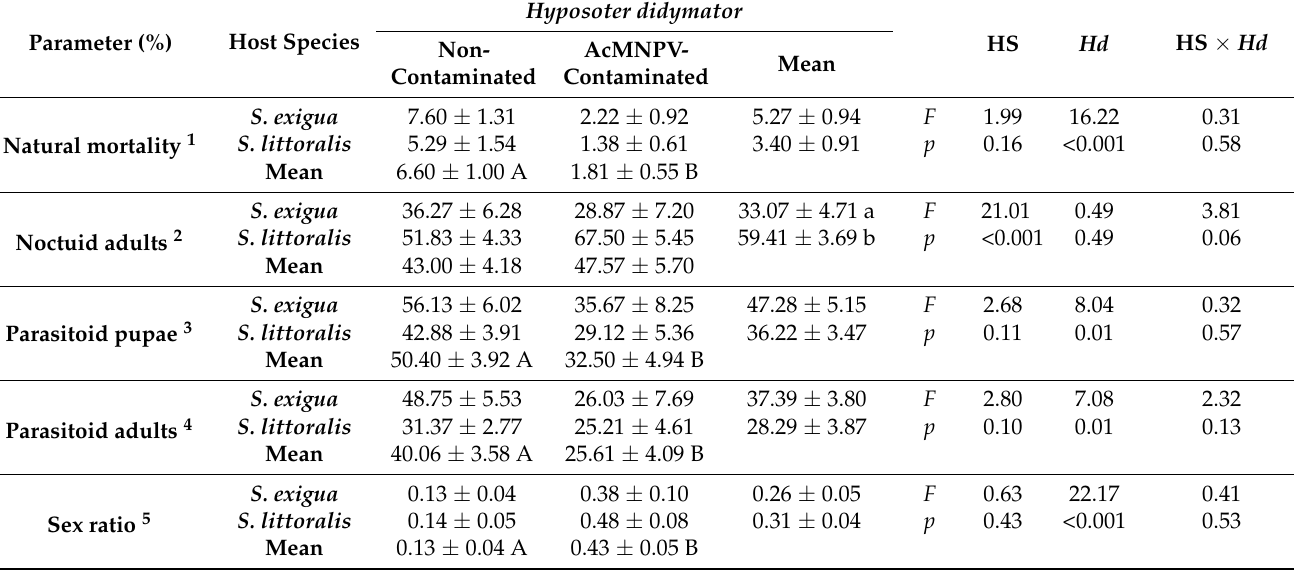
Table 2. Preference of Hyposoter didymator females for Spodoptera exigua and Spodoptera littoralis larvae under non-choice conditions. Influence of host species (HS; Spodoptera exigua or Spodoptera littoralis ) and status of the parasitoid Hyposoter didymator ( Hd ; which were or were not contaminated by Autographa californica multiple nucleopolyhedrovirus (AcMNPV) after previous exposure to infected larvae) on H. didymator reproductive parameters in relation to the number of larvae offered to the parasitoid: Percentages of larvae dead by natural causes non-attributable to parasitism (natural mortality), healthy Spodoptera adults that completed their development (noctuid adults), larvae dead by parasitism (parasitoid pupae), parasitoid adults, and sex ratio of the parasitoid offspring. Uppercase letters in the same row stand for significant differences between the status of the parasitoid. Lowercase letters in the same column stand for significant differences between the host